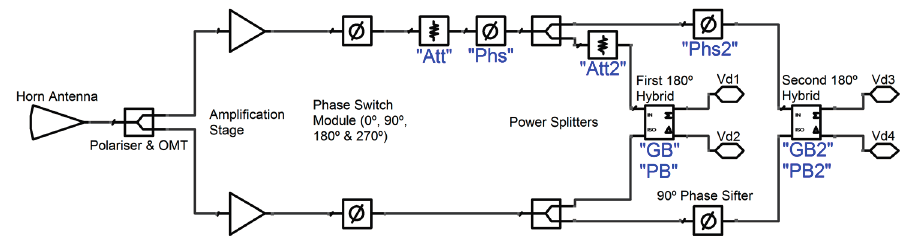
Figure 7. Simplified diagram of the polarimeter parametric